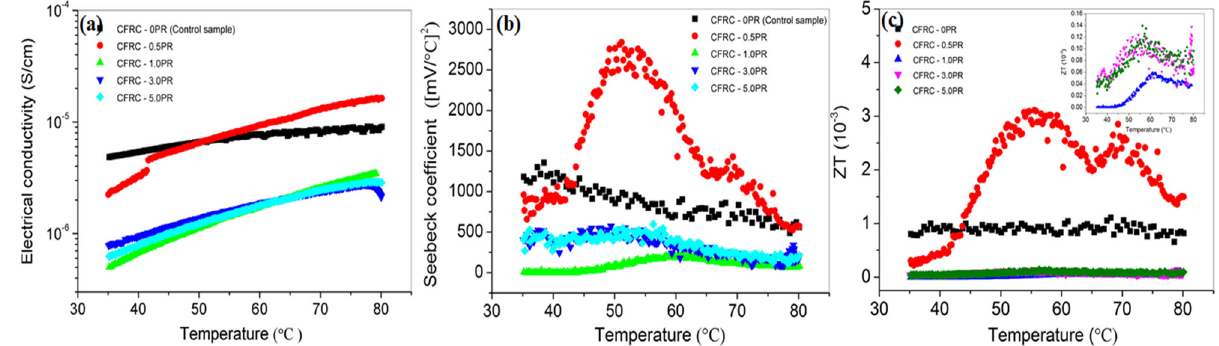
Figure 9. Thermoelectricity of CFRC prepared by treating CFs with different contents of phenolic resin. ( a ) Conductivity; ( b ) Seebeck coefficient; ( c ) ZT [93]. Table 4. Thermoelectric properties of CFRC.